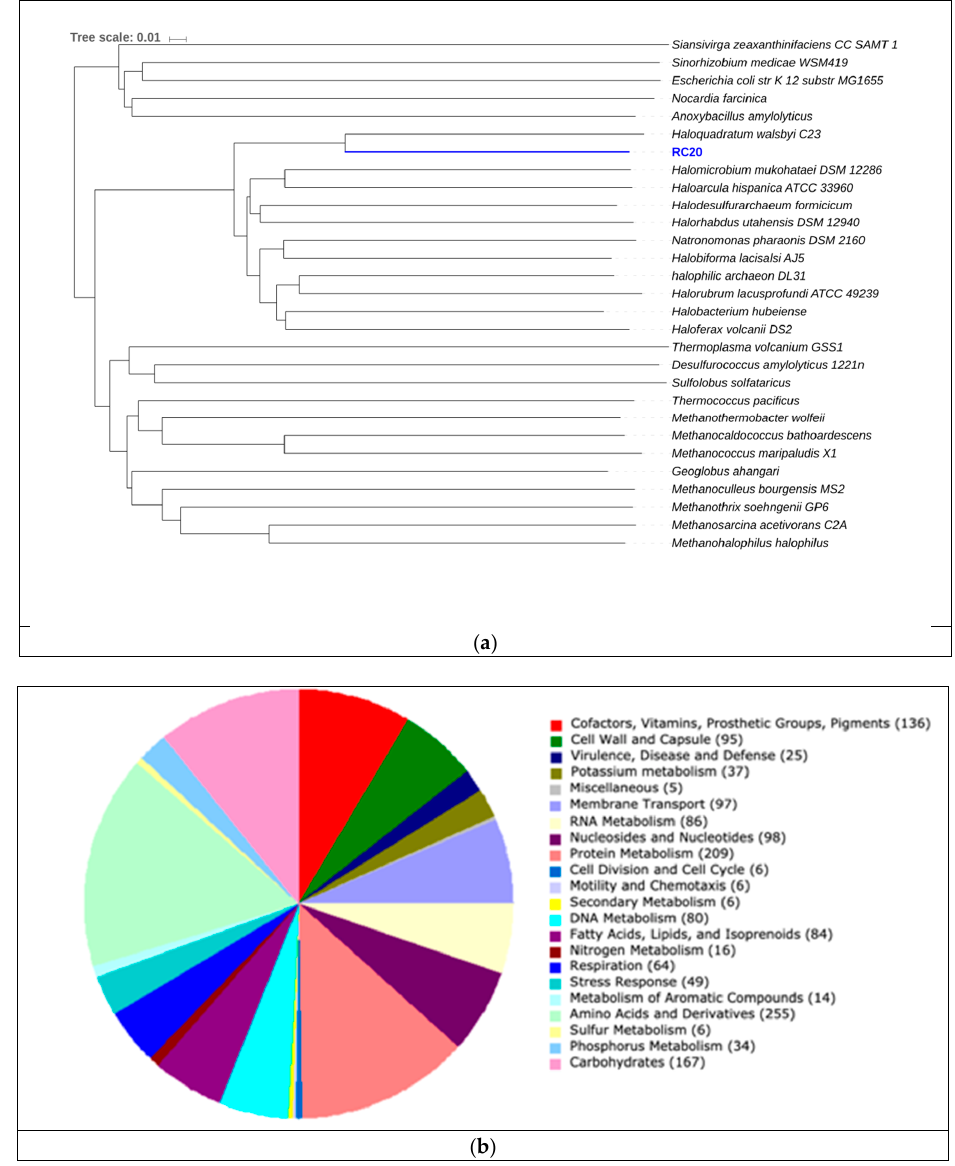
Figure 10. ( a ) Phylogeny for RC20 using AAI. The scale represents the amount of amino acid identity change over time. ( b ) Subsystem category distribution BIN20. The graph represents the number of proteins that were grouped into a specific subsystem; 1579 of 4980 coding sequences were identified to fit into subsystems. This chart was generated using Rapid Annotation System Technology (RAST).